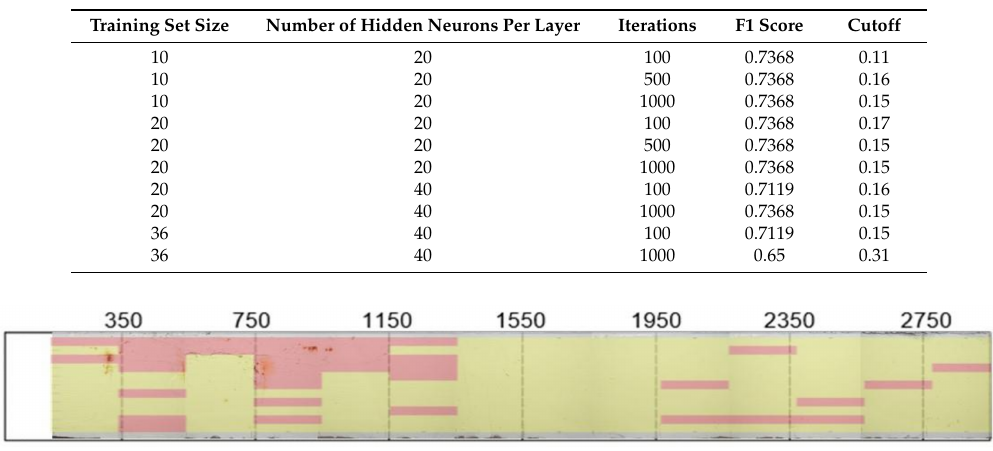
Table 4. Results from preliminary parameter analysis from 13,000 data points.